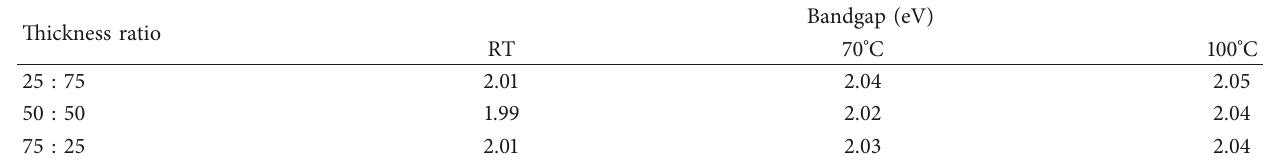
Table 1: Bandgap variation of InSe with different thickness ratios.